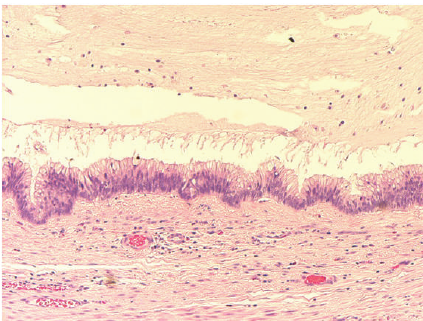
Figure 7: Photomicrograph showing mucinous tumour of uncer- tain malignant potential with mild pleomorphism and mild nuclear atypia. No invasion of the wall by neoplastic epithelium (original magnification × 10, hematoxylin and eosin stain).